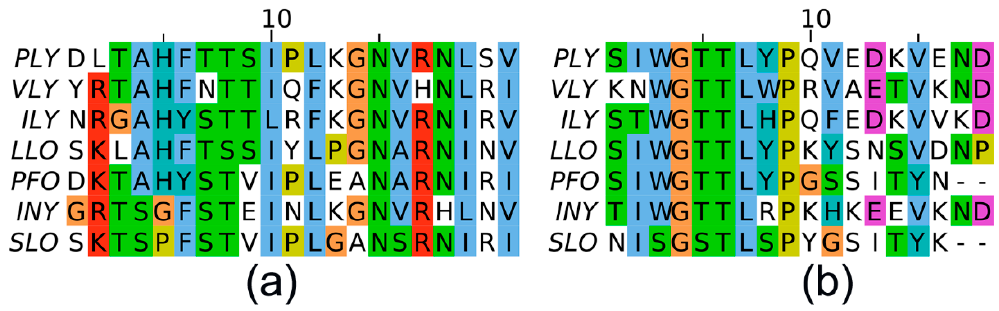
Figure 7. Sequence alignment of cytolysins (PLY, ILY, VLY, PFO, LLO, INY and SLO) representing binding sites for the neutralising MAbs: aa 403–423 recognition site of the MAb 12D10 ( a ), aa 454–471 recognition site of the MAbs 3A9, 6E5, 12F11 ( b ).